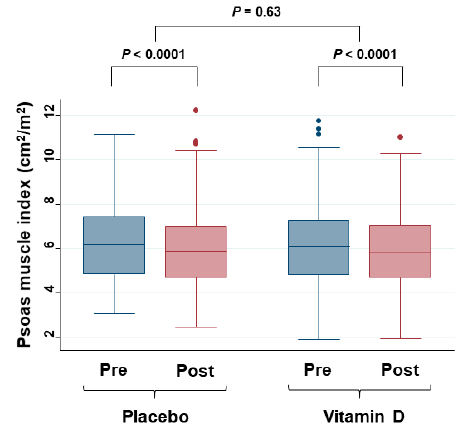
Figure 4. Box plot of changes in serum PMI values in the placebo group and the vitamin D group. Pre = at diagnosis; Post = 2 years after starting supplementation. Changes between pre and post were evaluated with the Wilcoxon signed-rank test, and the change ratio ((post–pre) / pre) was compared between the placebo group and the vitamin D group by the Mann–Whitney test.